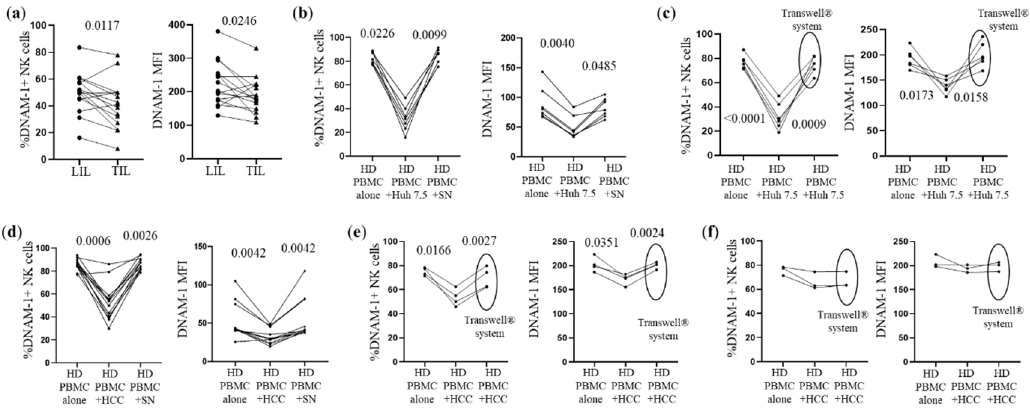
Figure 3. DNAM-1 is downregulated upon exposure to tumor cells. ( a ) Proportion of DNAM-1+ NK cells in LIL and matched TIL and DNAM-1 expression (as MFI) measured ex vivo by flow cytometry. The paired t-test was used to compare data. ( b ) The frequency of DNAM-1+ NK cells and DNAM-1 MFI was analyzed in NK cells from seven HDs in the presence or absence of Huh 7.5 cells or cell-free supernatant (SN) from Huh 7.5 cell cultures. ( c ) The frequency of DNAM-1+ NK cells and DNAM-1 MFI were determined in PBMCs, after exposure to Huh 7.5 cells or in the Transwell ® system to prevent contact with Huh 7.5 cells (HD, n = 6). ( d ) Downregulation was assessed after co-culture of PBMCs from 13 HDs with 5 primary HCC cells or with HCC cell culture SN. ( e ) DNAM-1 downmodulation in NK cells from four HDs co-cultured with primary HCC cells expressing CD155. ( f ) The experiments were repeated using primary HCC cells expressing low levels of CD155. The non-parametric Friedman test for matched data was used for comparisons.